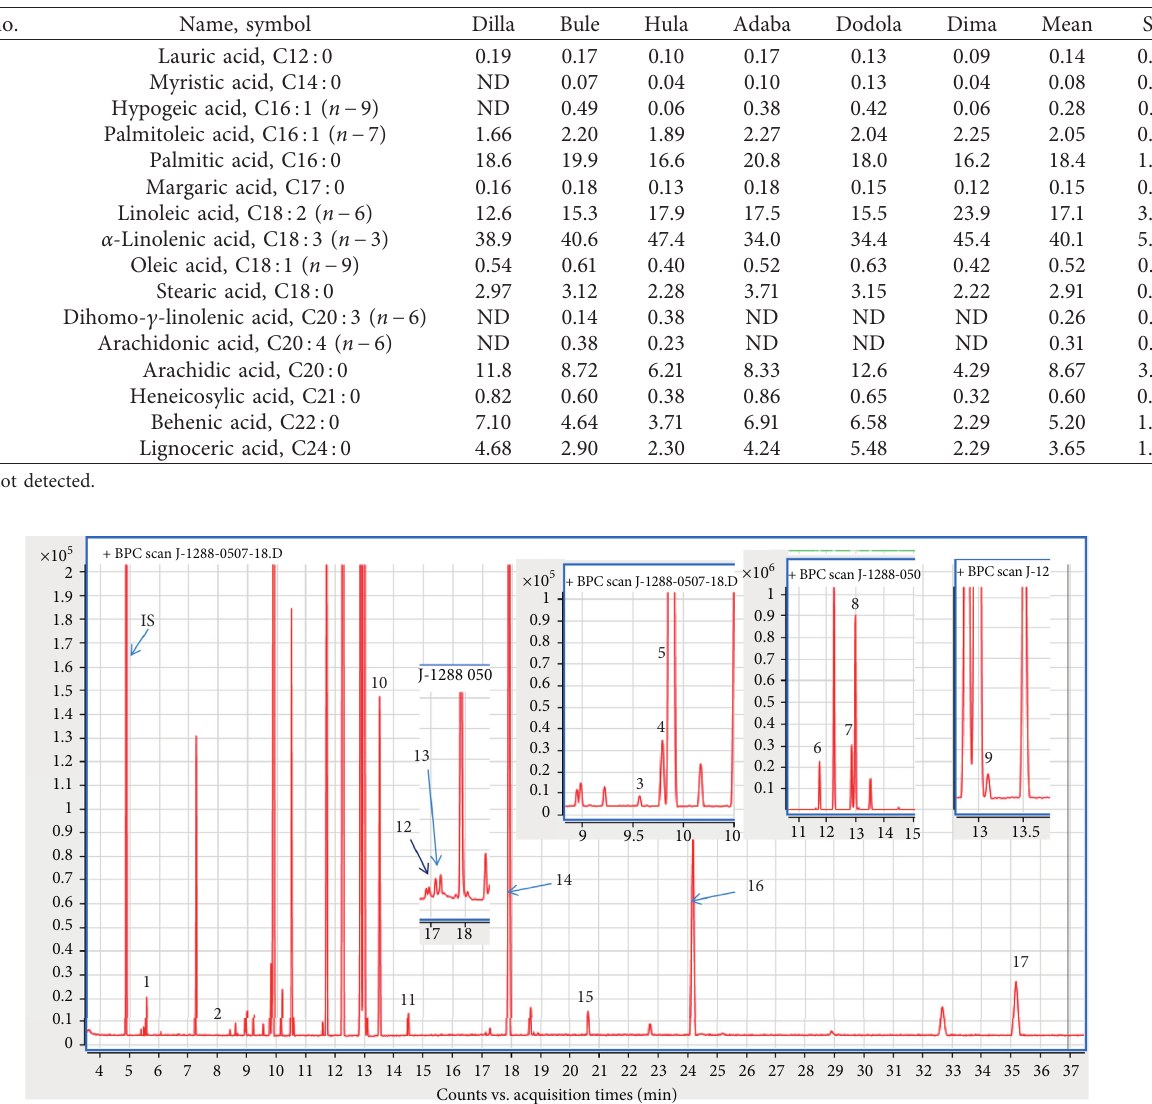
Figure 1: GC-MS chromatogram of methyl esters of fatty acids present in leaves of Urtica simensis collected from Hula district. IS is an internal standard (undecanoic acid).